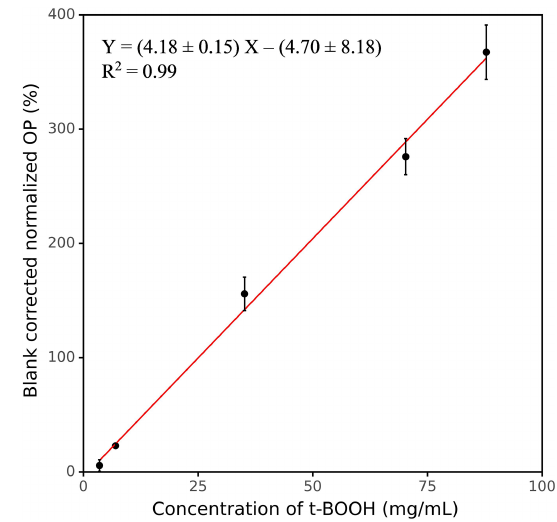
Figure 3. OP as a function of the concentration of t-BOOH, mea- sured by our automated instrument. The values on the y axis were obtained by dividing the absolute fluorescence of the sample by the absolute fluorescence of negative control and then blank-correcting it (i.e., subtracting 1 from ratio and then multiplying it by